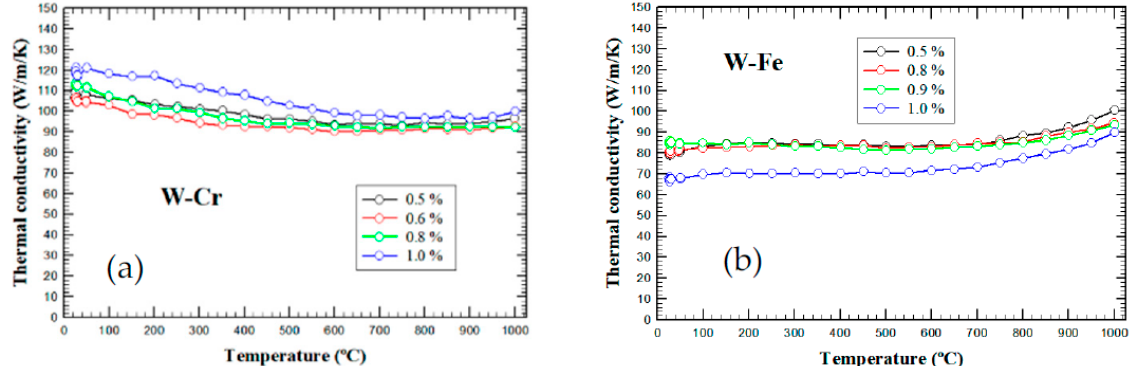
Figure 9. Temperature-dependent thermal conductivity of W-metal composites for different disper- sion concentrations: ( a ) W-Cr materials and ( b ) W-Fe materials. sion concentrations: ( a ) W-Cr materials and ( b ) W-Fe